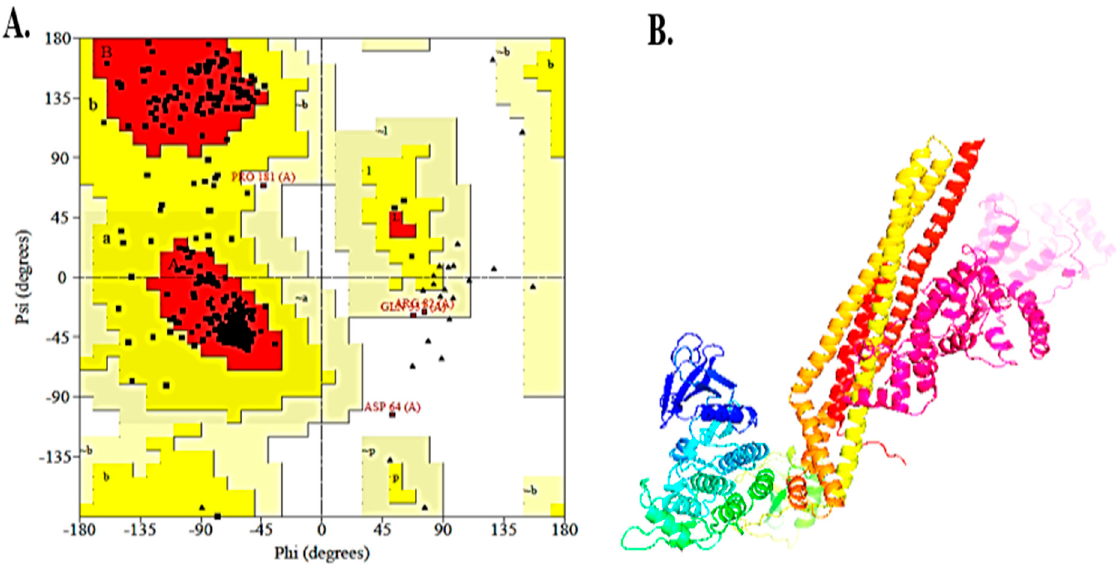
Figure 6. ( A ) Ramachandran Plot by PROCHECK Server; 90.7% of residues are in the core region, 8.5% lie in allowed zones and 0.3% are in disallowed region; ( B ) The docked complex via Cluspro, visualized on PyMol with a minimum energy score of − 7.4 and 129 clusters. The colors indicate the different chains of the rector and the vaccine construct. The pink, orange, and yellow colors show the chain of the receptor molecule, whereas green, cyan, and blue indicate the vaccine molecule.